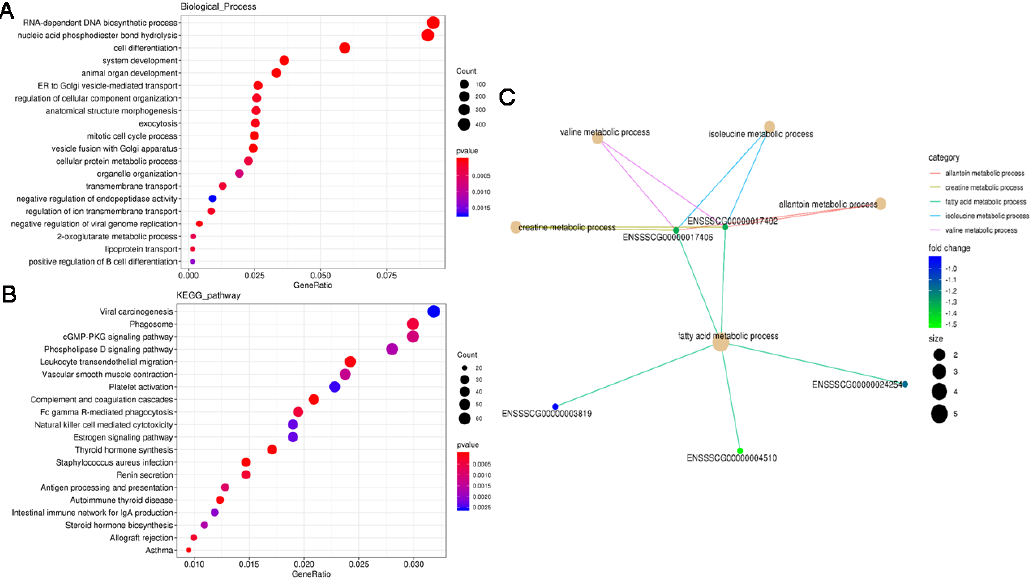
Figure 4. GO and KEGG pathway analysis of the PTGs of DE lncRNAs. ( A ) GO biological process analysis for all DE lncRNAs. ( B ) KEGG pathway analysis for all DE lncRNAs. ( C ) Gene network of PTGs enriched in fatty acid metabolism via cis -regulation.